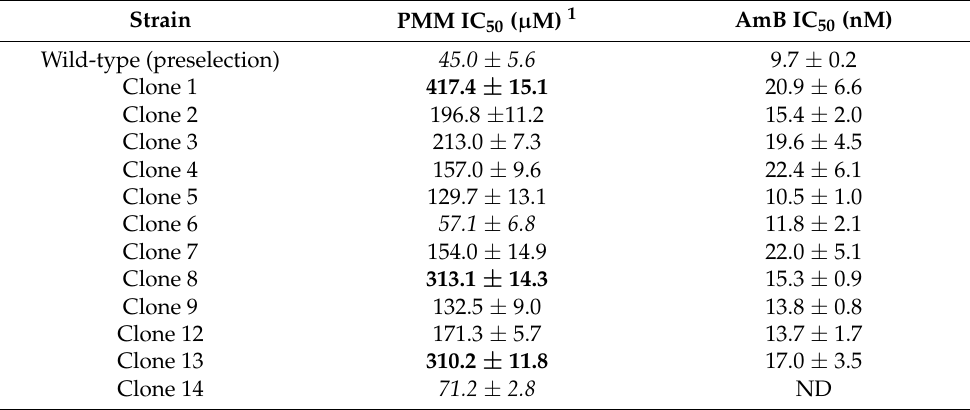
Table 1. Intracellular amastigote IC 50 values of the pre-selection population and the 12 different post-selection clones against paromomycin (PMM) and amphotericin B (AmB). Results are expressed as the average IC 50 (in µ M) ± the standard error of the mean (SEM). The clones that were considered resistant (resistance index (RI) > 5) are indicated in bold. Those considered susceptible (RI < 2) are indicated in italics. All reported IC 50 values are the result of at least two independent experiments run in